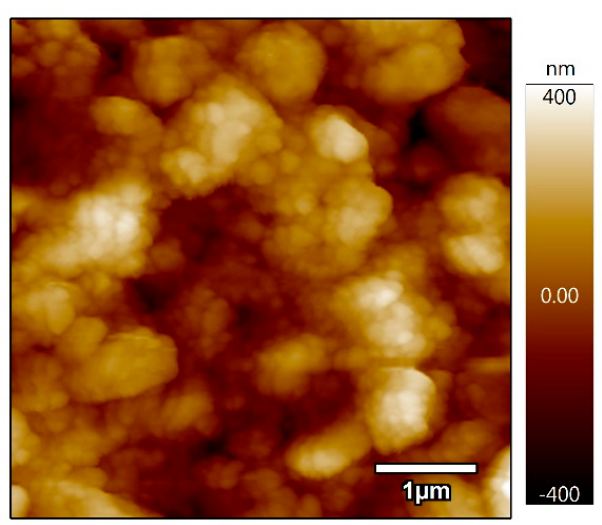
Figure 7. Atomic force microscopy (AFM) image of the Al 2 O 3 mesoporous thin film.